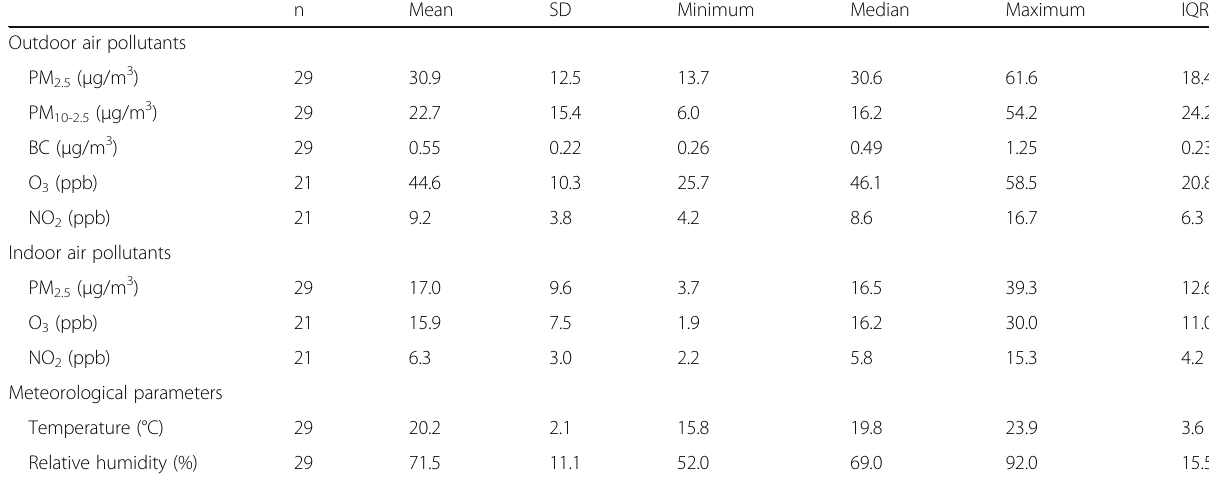
Table 2 The 24-h mean concentrations of outdoor and indoor air pollutants and meteorological parameters during the study period